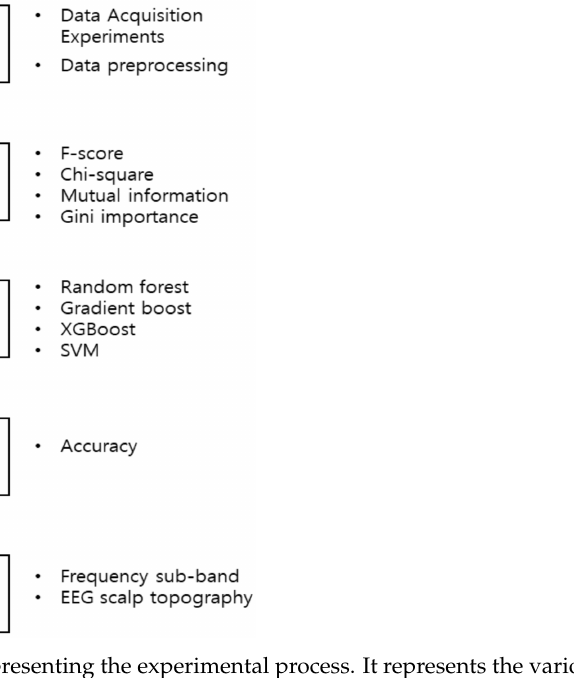
Figure 2. Diagram representing the experimental process. It represents the various methodologies and work content utilized at each